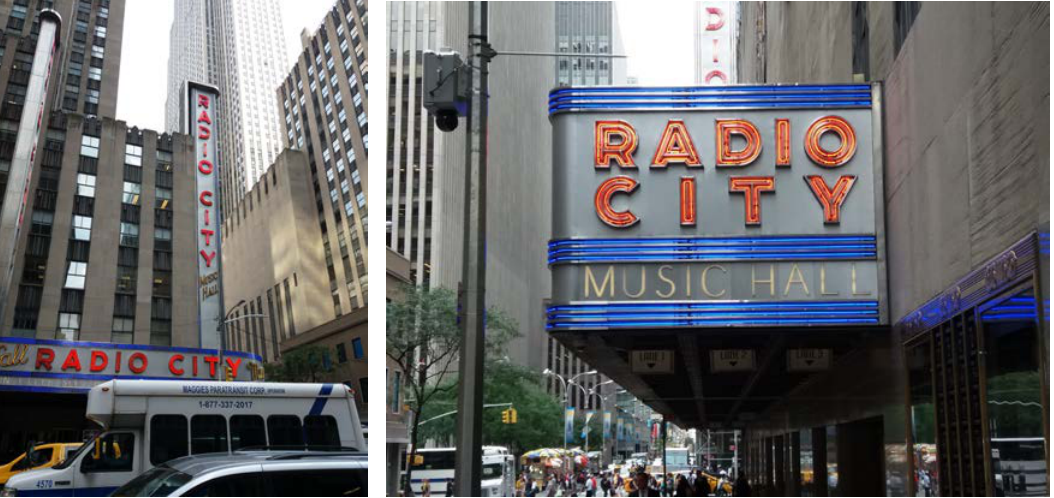
Figure 9: Radio City Music Hall as an emblematic international musical and urban